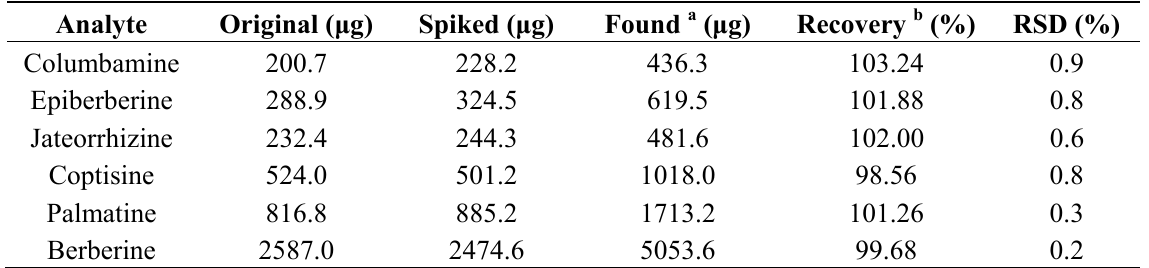
Table 4. Recoveries for sample spiked with investigated alkaloids (n = 3).